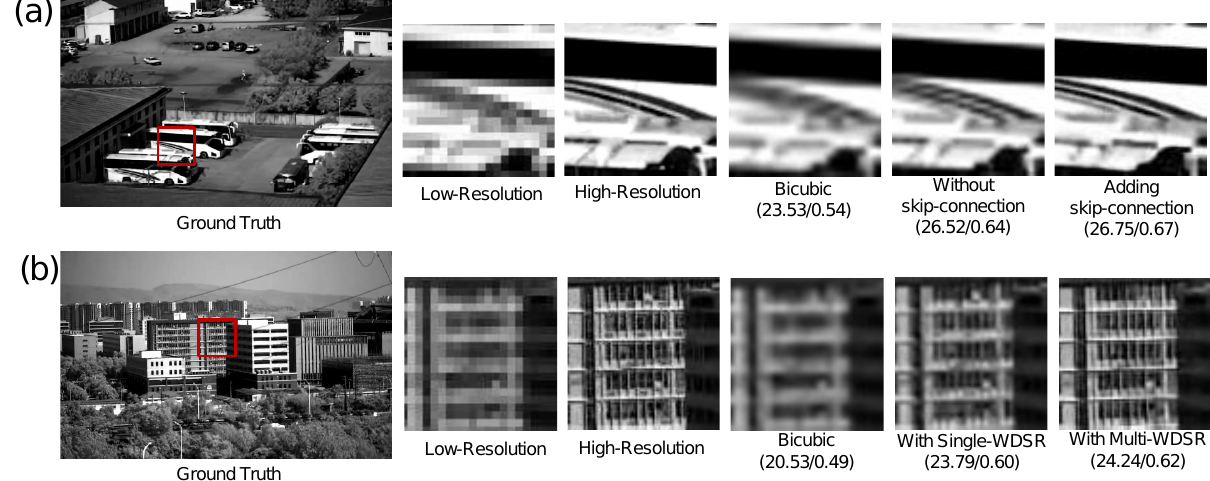
Figure 4. The comparison experiment of various network structure parameters. ( a ) Comparison of the skip connection residual structure. ( b ) Comparison of multiple wide activation residual